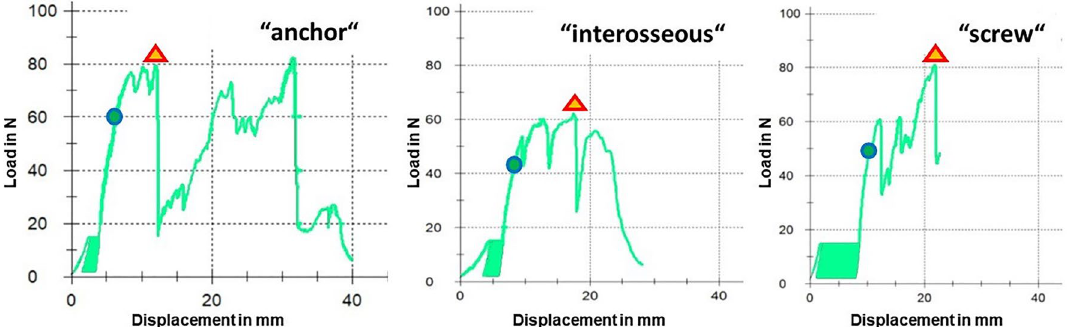
Figure 5. Exemplary load versus displacement curve-graphs for each particular repair technique. The circle marks the point of measurement of the “load at the first noteworthy displacement (2 mm)”. The triangle indicates the “load at failure” assessment